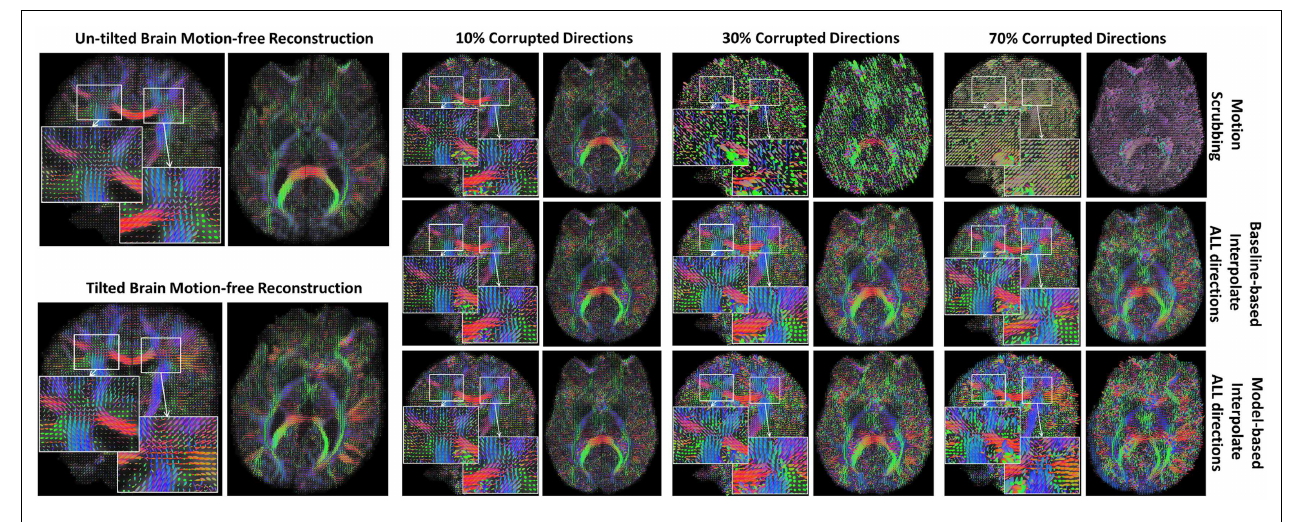
FIGURE 4 | Sample fODFs reconstruction from untilted and tilted motion-free datasets as well as reconstruction from motion-corrected datasets with 10, 30, and 70% corrupted gradient